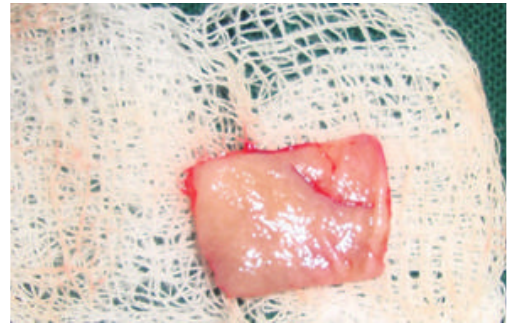
Figure 15: The donor tissue.